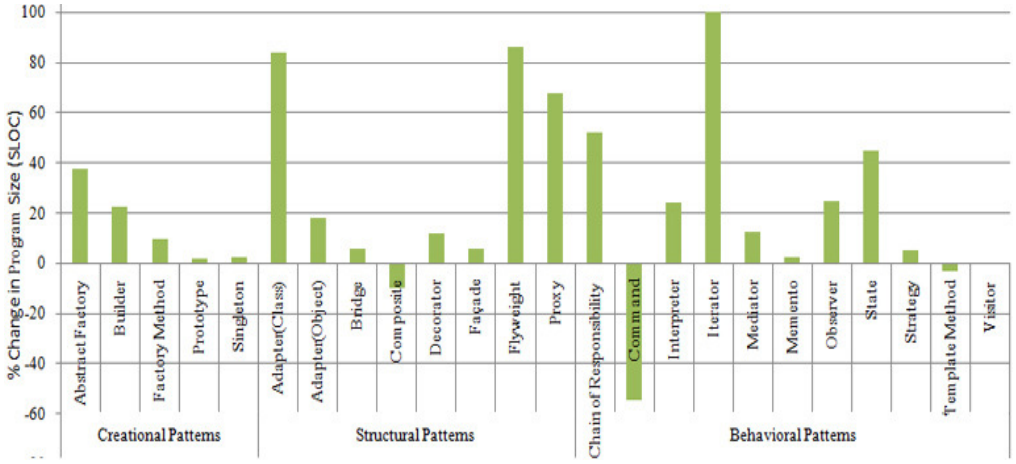
FIG 5: .IMPACT OF DESIGN PATTERNS ON PROGRAM SIZE